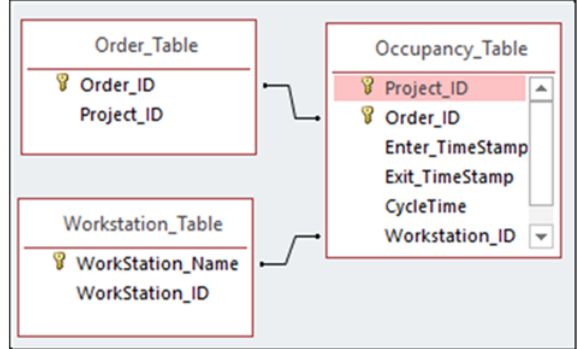
Figure 5. Relational database storing the state of workstations.